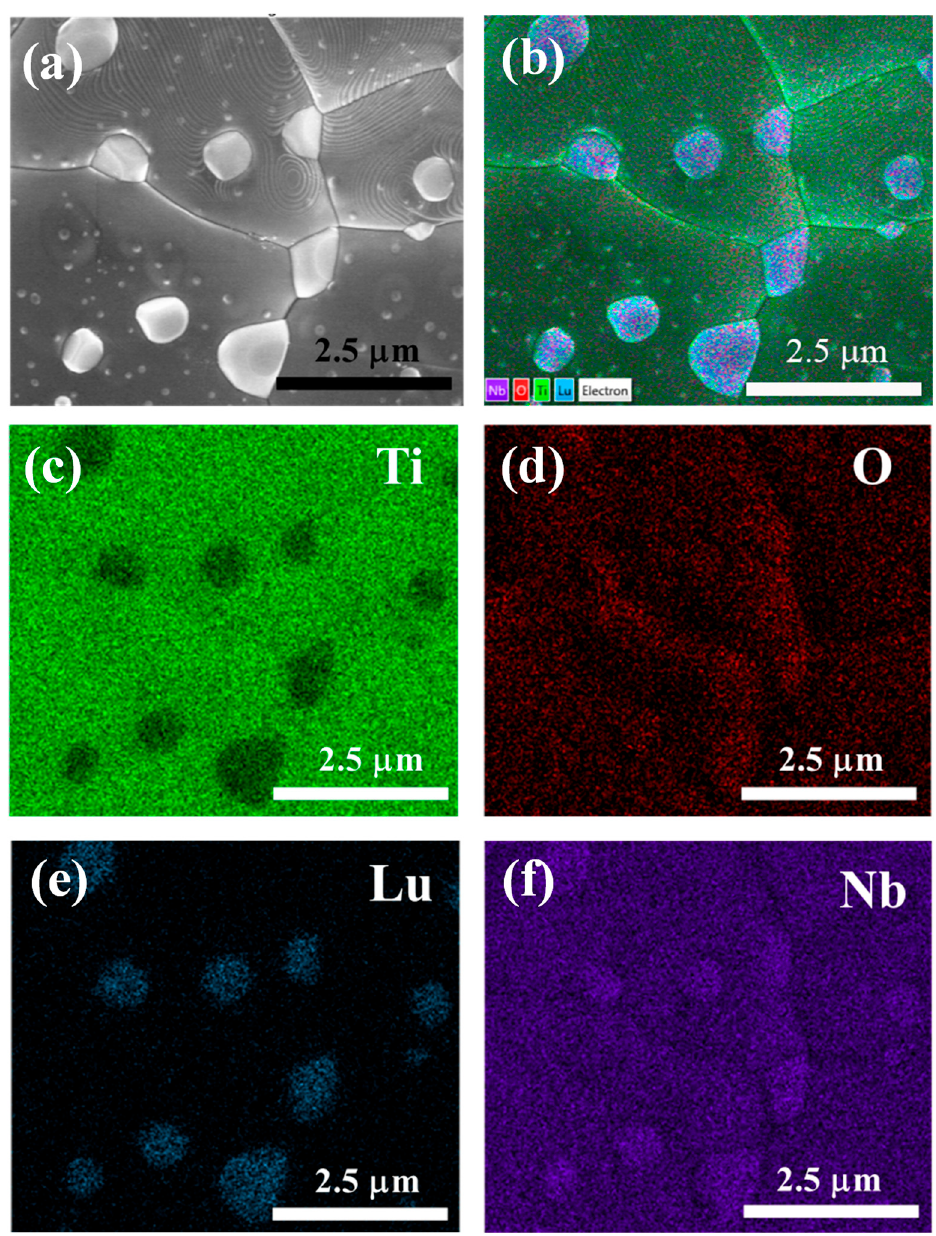
Figure 3. SEM ‐ EDS mapping images of LuNTO ‐ 2 ceramic; ( a ) SEM image for mapping area, ( b ) all Figure 3. SEM-EDS mapping images of LuNTO-2 ceramic; ( a ) SEM image for mapping area, ( b ) all elements, ( c ) Ti, ( d ) O, ( e ) Lu, and ( f ) Nb. elements, ( c ) Ti, ( d ) O, ( e ) Lu, and ( f )